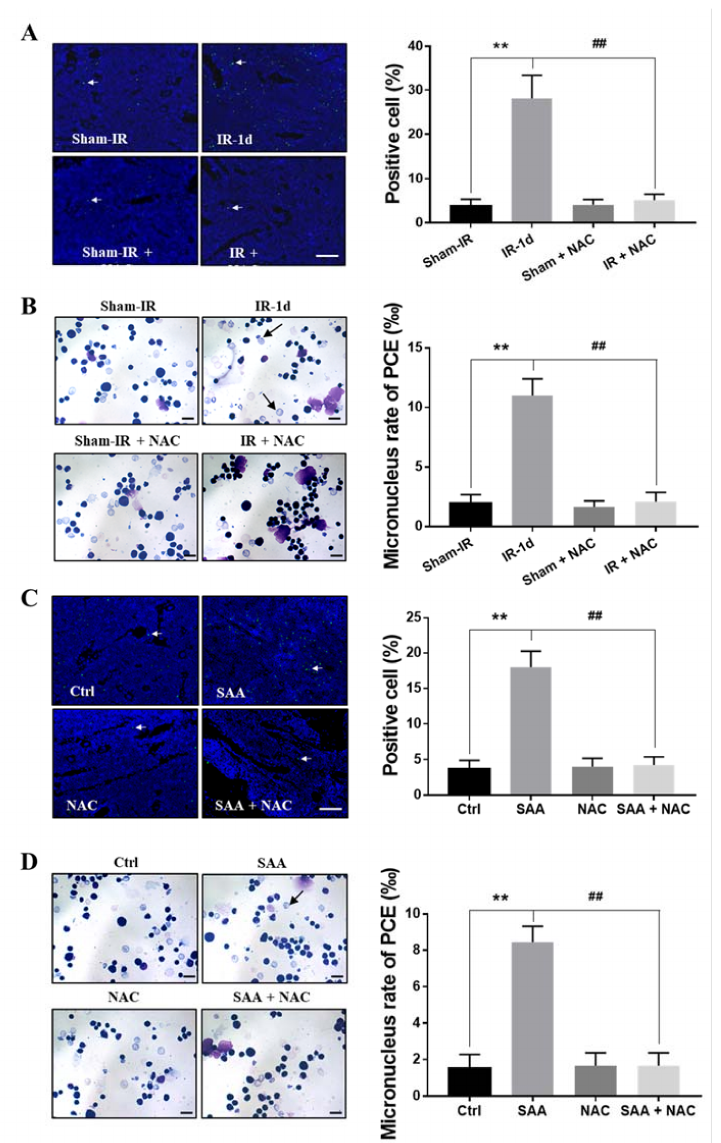
Figure 8. ROS scavenger NAC eliminated Th-IR/SAA-induced bone marrow damage in mice. The mice were injected subcutaneously daily with NAC (100mg/kg, dissolved in PBS) for three days before Th-IR (8 Gy × 3) or SAA treatment (intraperitoneally injection, 0.35 mg/kg). The bone marrow of mice was collected at day one after Th-IR or SAA injection. ( A , C ) TUNEL staining and TUNEL-positive cells. White arrows represent the TUNEL positively stained cells. Bar = 100 µ m. ( B , D ) PCEs staining and micronucleus formation. Black arrow, micronucleus in PCEs. ** p < 0.01 indicated a significant difference with sham/Ctrl group; ## p < 0.01 indicated a significant difference with IR/SAA group. Bar = 10 µ m. n =